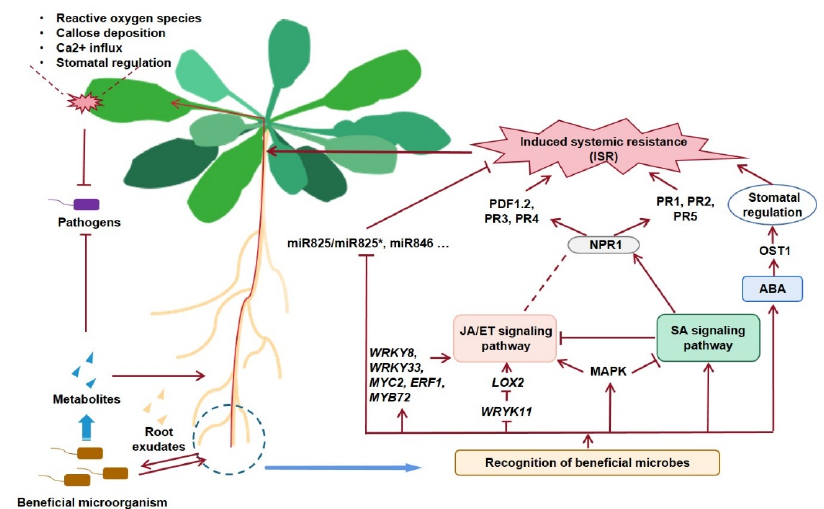
Figure 1. Working model of beneficial microorganism-mediated ISRIn the next stage, there are still some problems to be solved. More microbial germplasm resources with biocontrol potential remains to be discovered; the formulation and shelf life of bacteria need to be improved; mining and identi- fication of new antibacterial substances and analysis of their biosynthesis pathway, research on the genetic regulatory network of biosynthesis and microbial metabolites, and its application, based on genetic modification, are also interesting topics. Efficient and stable RNAi technology requires mas- tering the proper design and synthesis of dsRNA. The screening carriers of dsRNA are also indis- pensable to develop and improve the application of RNAi technology in plant disease control. Author Contribtions: D.N. conceived study; Y.Y., Y.G. and D.N. wrote the article; D.N., Y.Y., Z.L., C.J. and J.G. edited the manuscript; D.N., Y.Y. and Y.G. created and edited the figures. All authors have read and agreed to the published version of the manuscript. Funding: This work was supported by the Natural Science Foundation of Jiangsu Province (BK20211524) and the National Natural Science Foundation of China (32072404). Institutional Review Board Statement: Not applicable. Informed Consent Statement: Not applicable. Data Availability Statement: Not applicable. Conflicts of Interest: The authors declare no conflict of interest. References 1.